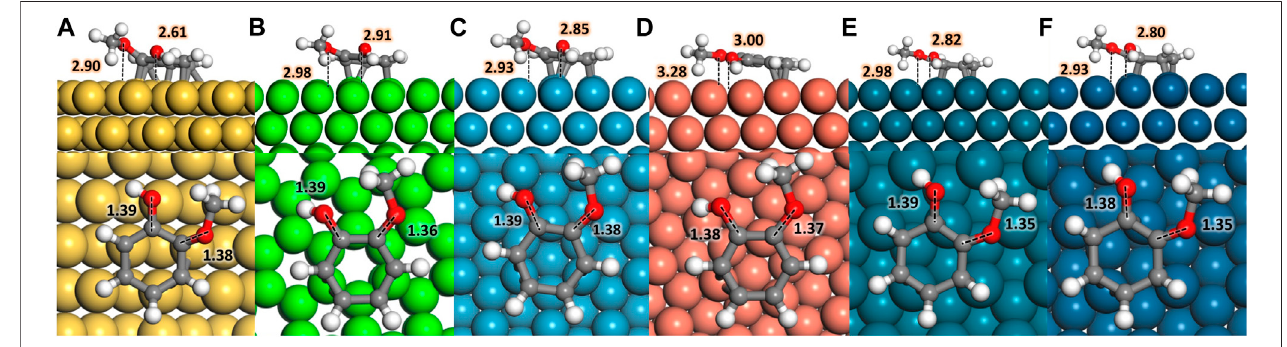
FIGURE 1 | Top and side views of guaiacol adsorbed on (A) Fe (110), (B) Co (0001), (C) Ni (111), (D) Cu (111), (E) Pd (111), and (F) Pt (111); the metal atoms are representedinyellow,lightgreen,blue,orange,darkgreen,anddarkbluecolourcode,respectively.Red,white,andgreyrepresentoxygen,hydrogen,andcarbon.Inset distances are given in